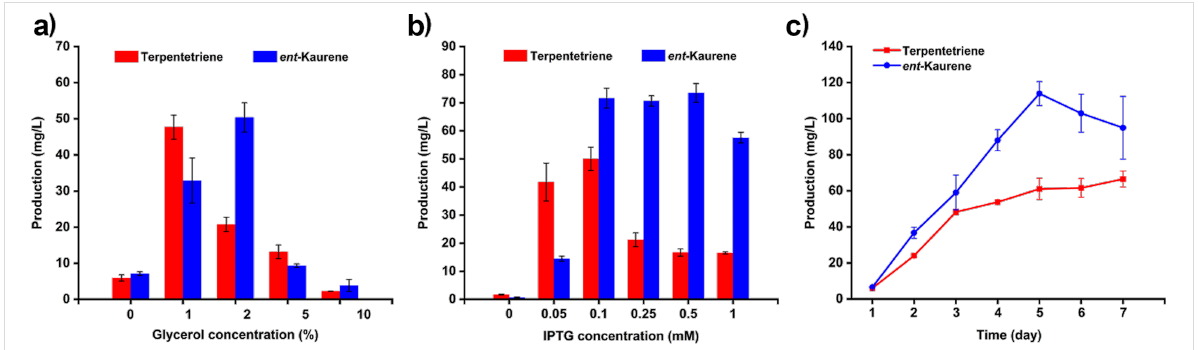
Figure 5: (a) Terpentetriene (red) and ent -kaurene (blue) yields supplied with various concentrations of glycerol. (b) Terpentetriene (red) and ent - kaurene (blue) yields induced with different concentrations of IPTG. (c) Time course analysis (1–7 days) of terpentetriene (red) and ent -kaurene (blue). All product yields are reported as means ± SD of three